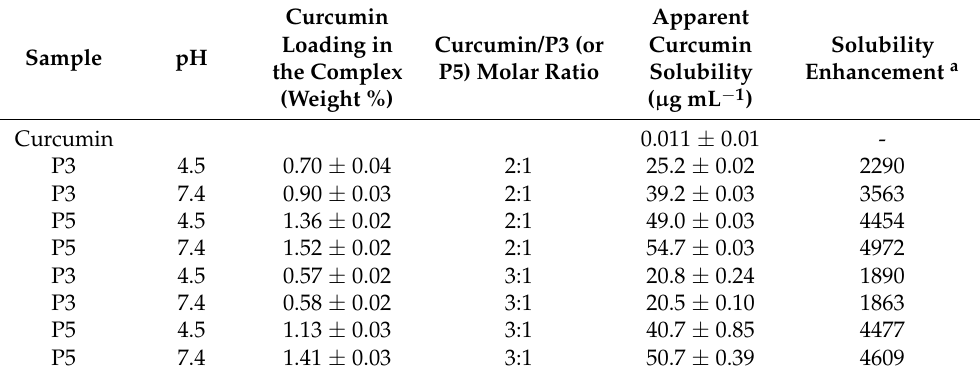
Table 2. Apparent solubility of curcumin in the form of P3- or P5-complex versus solubility of free